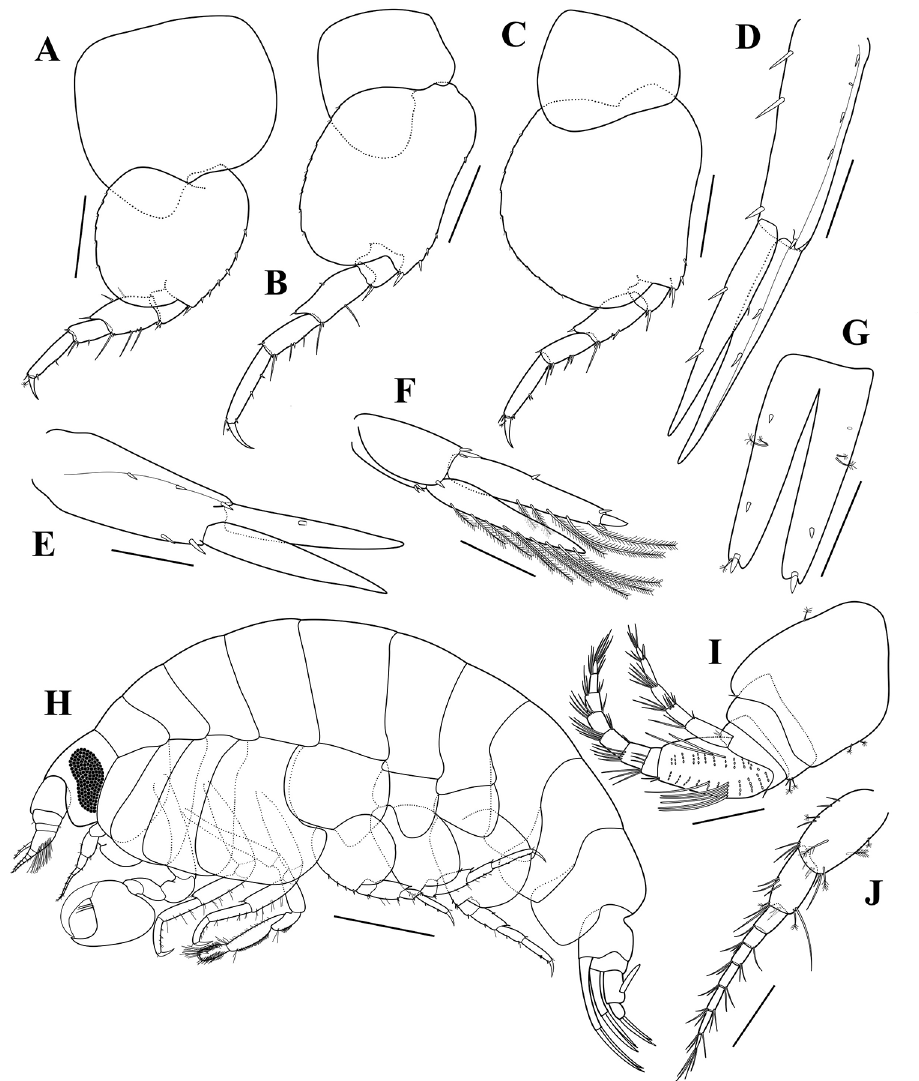
Figure 7. Opisa takafuminakanoi Narahara-Nakano, Kakui & Tomikawa, 2016, adult male, NI- BRIV0000880624, 8.8 mm A pereopod 5 B pereopod 6 C pereopod 7 D uropod 1 E uropod 2 F uropod 3 G telson. Adult female, NIBRIV0000880625, 8.7 mm H habitus I antenna 1 J antenna 2. Scale bars: 0.4 mm ( A–C ), 0.2 mm ( D–G, I–J ), 1.0 mm ( H ).